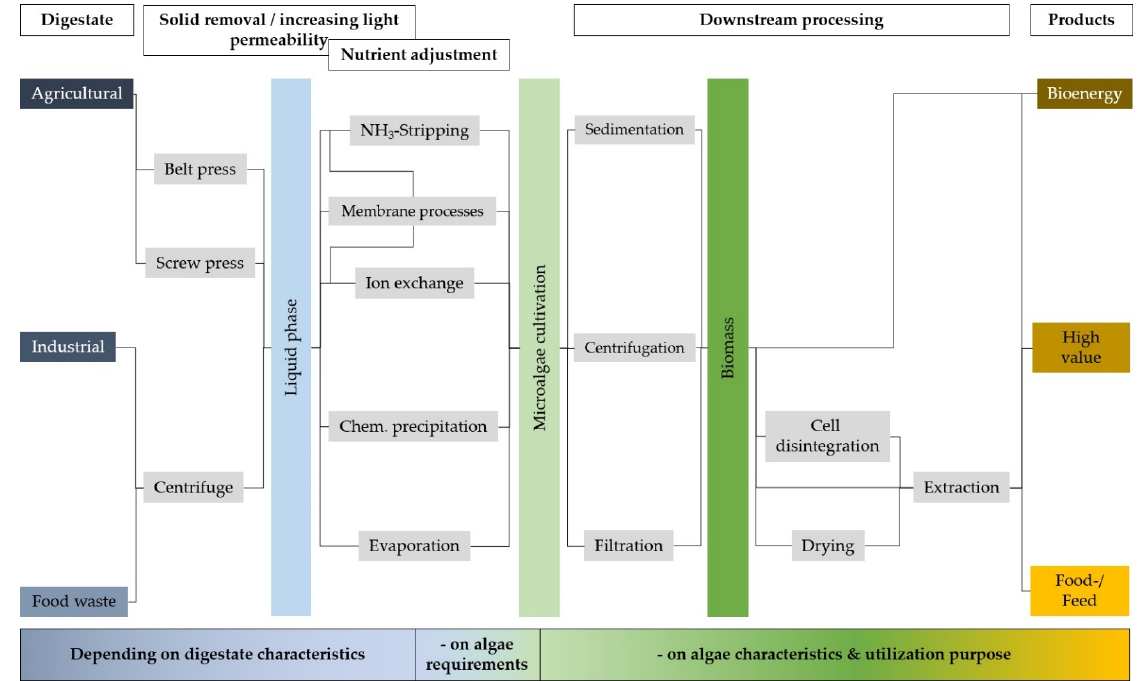
Figure 1. Overview of possible process steps for obtaining microalgae products by using digestate as nutrient source. Solids separation during digestate processing and microalgae harvesting can be enhanced by using precipitating or flocculating agents.